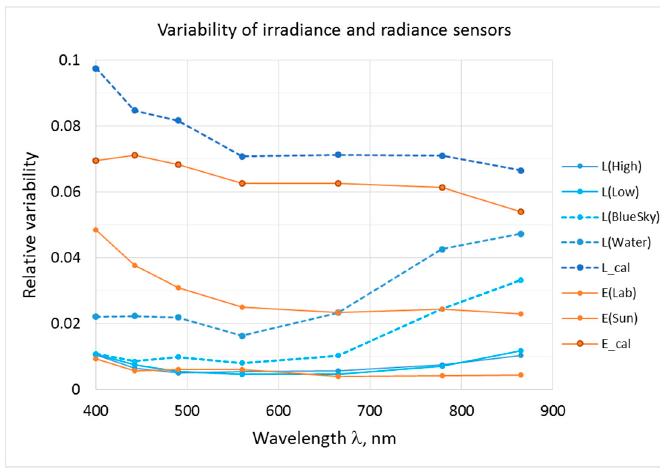
Figure 12. Variability between irradiance and radiance sensors. E_cal and L_cal—due to calibration state; E(Lab), L(Low) and L(High)—variability in laboratory intercomparison; E(Sun), L(BlueSky) and L(Water) variability in the field.